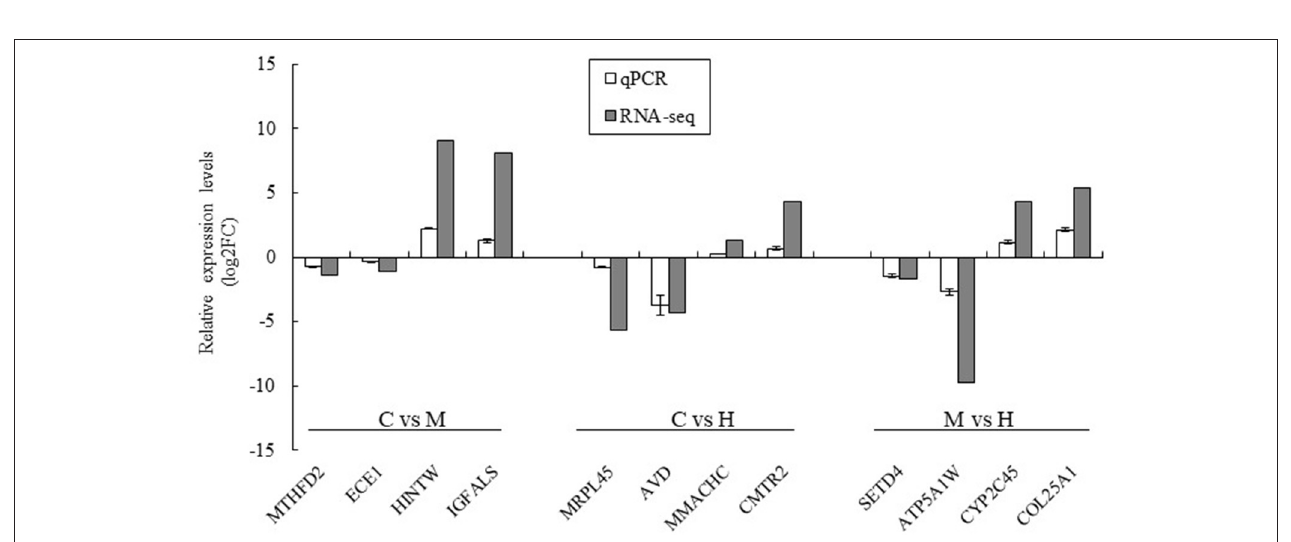
FIGURE 5 | The top 10 ranked hub genes obtained from CytoHubba analysis based on degree method. The change in color from red to yellow represents a change in degree score from high to low.